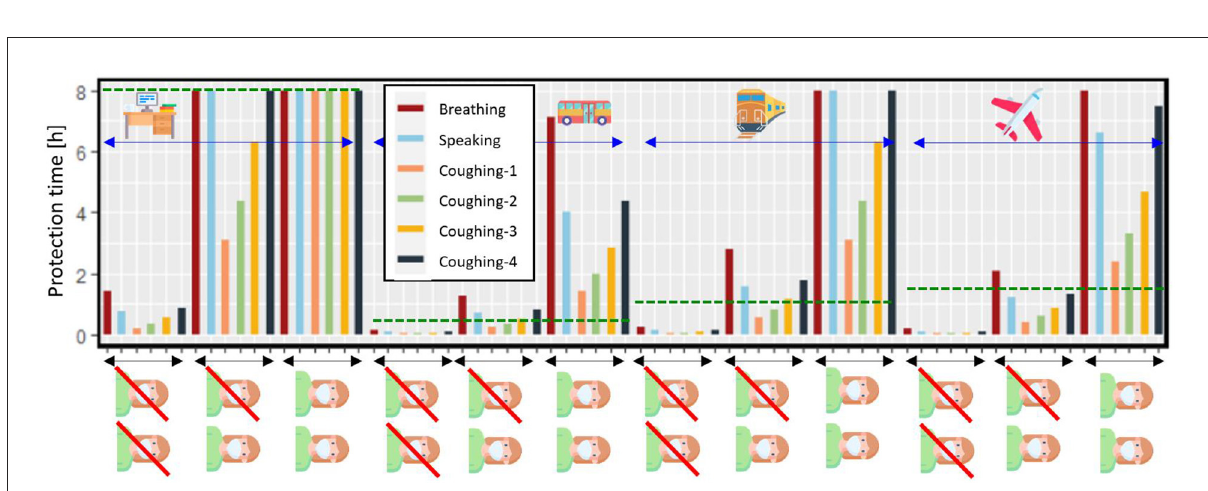
FIGURE8 Protection time for a healthy person in close contact with an infected person in office room, bus, train, and airplane, with or without surgical mask IIR, by considering the infected person’s breathing, coughing, and speaking. The dashed green line represents the average staying time in each environment (the icons are from